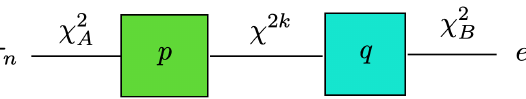
Figure 16 . Calculating the partition function in the each k sector is equivalent to calculating the partition function for finding the n -th moment of an effective two-tensor model (up to a normal- ization factor) with two external bonds with bond dimensions χ 2 bond with dimension χ 2 k